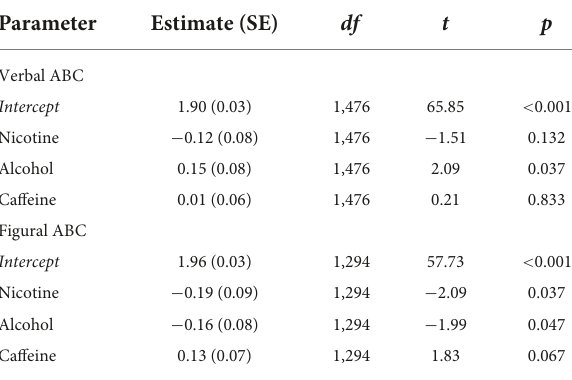
TABLE 5 Multilevel model for the consumption of alcohol, caffeine, and nicotine predicting performance in the verbal and the figural